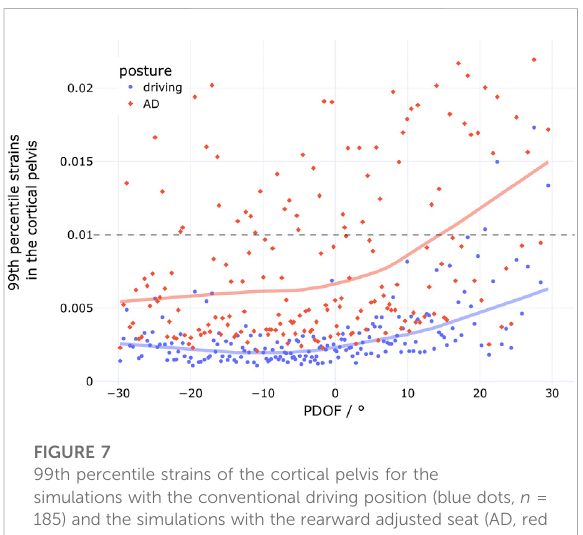
FIGURE 7 99th percentile strains of the cortical pelvis for the simulations with the conventional driving position (blue dots, n = 185) and the simulations with the rearward adjusted seat (AD, red diamonds, n =